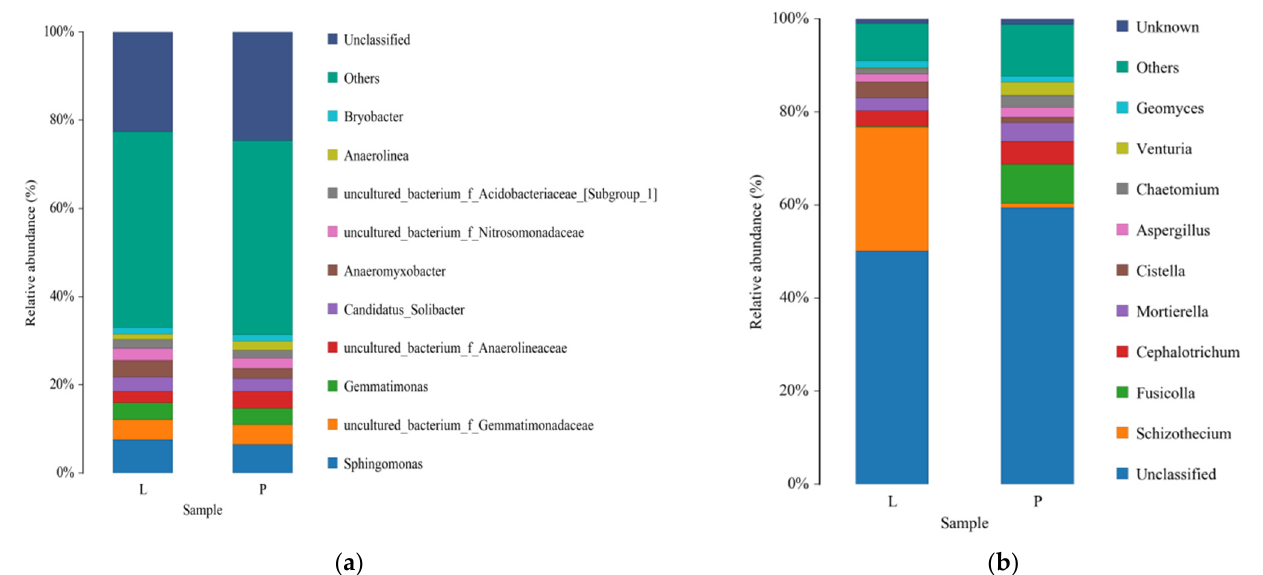
Figure 4. Changes in relative abundances of ( a ) soil bacteria and ( b ) fungi at the genus level. L: ridge tillage at two fertilizer depths; P: conventional cultivation.